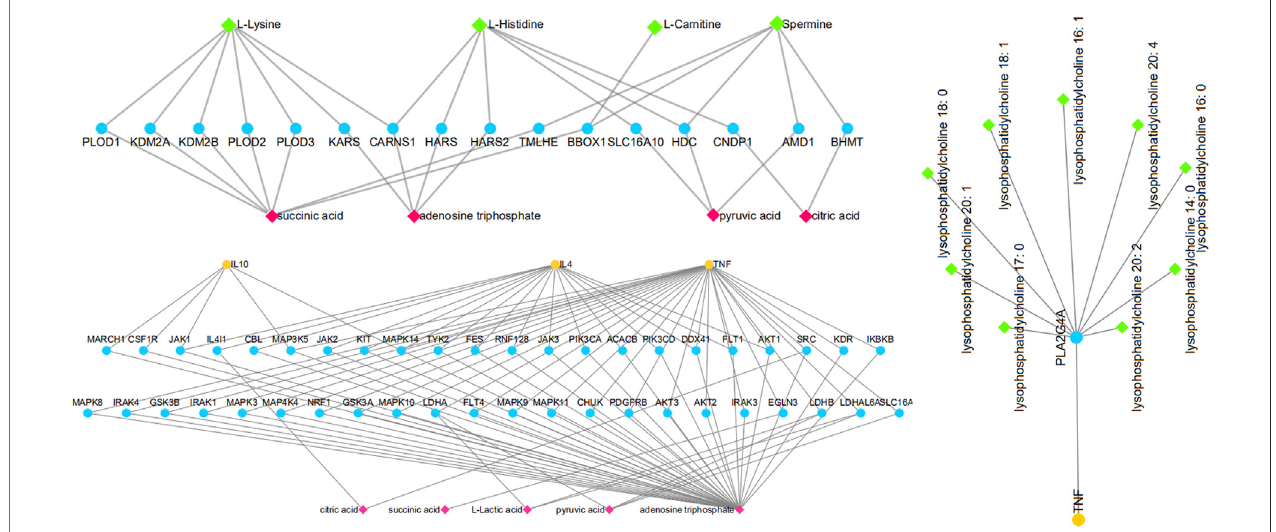
FIGURE 12 | The protein-enzyme/transporter-metabolite network analysis of differentially expressed biomarkers based on multiple in fl uencing factors and multi- omics analysis. Green represents different metabolites; Red represents energy metabolism factors; Yellow represents in fl ammatory factors; Blue represents metabolic